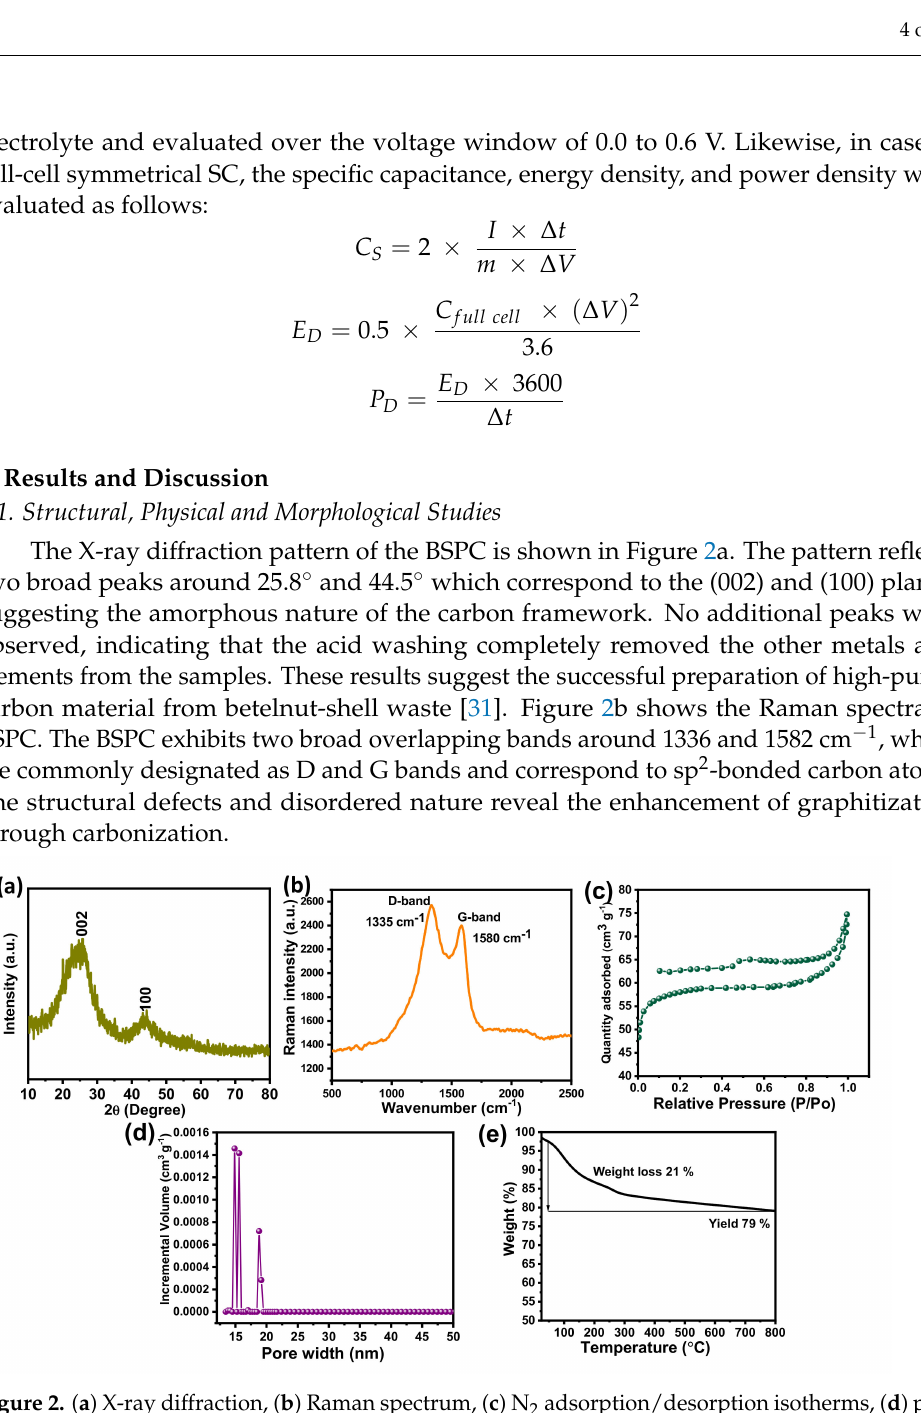
Figure 2. ( a ) X-ray diffraction, ( b ) Raman spectrum, ( c ) N 2 adsorption/desorption isotherms, ( d ) pore size distribution, and ( e ) TGA analysis of the